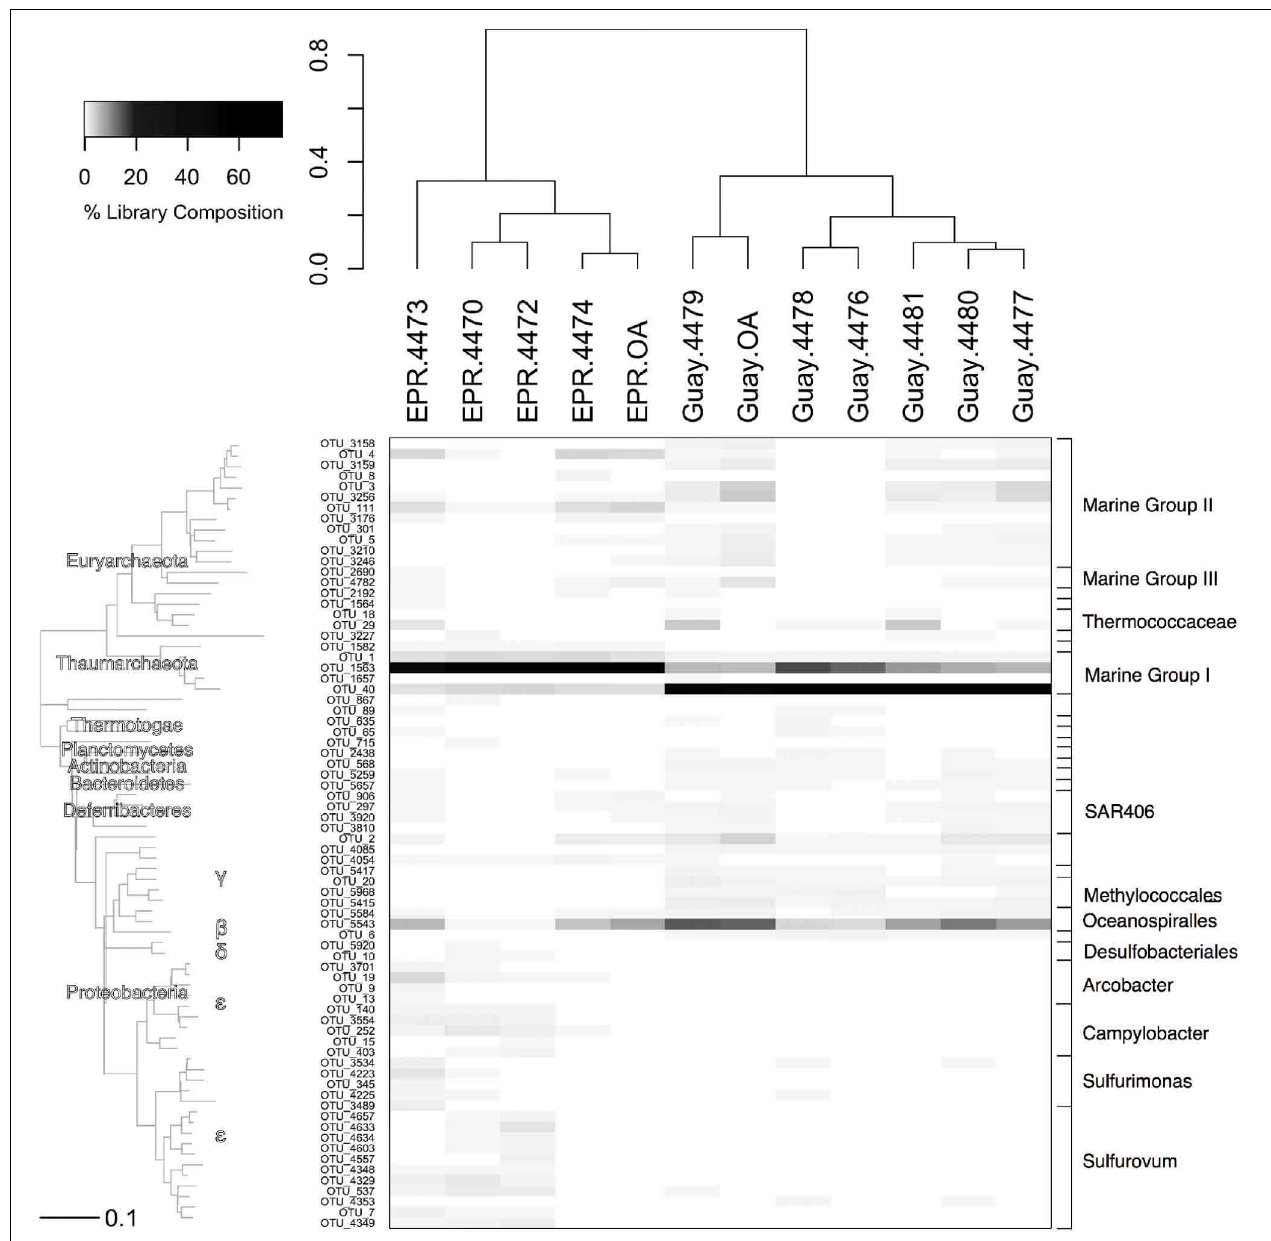
FIGURE 5 | Relative abundance of OTUs from the entire microbial community of the indicated sample with their corresponding phylogeneticaffiliation. Sample communitieswere clustered with a Bray-Curtis similarity measurementbased on relative abundancedata of each